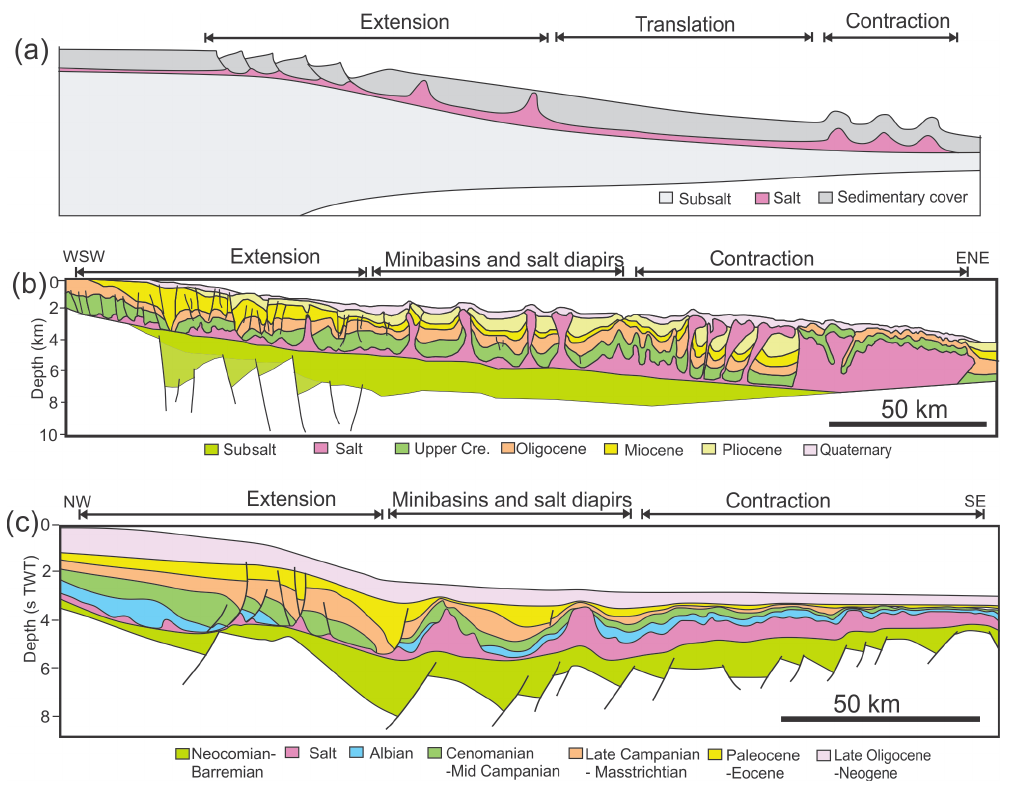
Figure 1. (a) Simplified cross section illustrating the kinematic domains and structural styles in a typical passive margin salt basin (modified after Rowan et al., 2004; Brun and Fort, 2011). (b) Regional interpreted seismic profile crossing the Lower Congo Basin (modified after Marton et al., 2000). Note the minibasins and diapirs in the mid-slope. (c) Regional interpreted seismic profile crossing the central Santos Basin (modified after Modica and Brush, 2004). Note the large minibasins and diapirs in the mid-slope